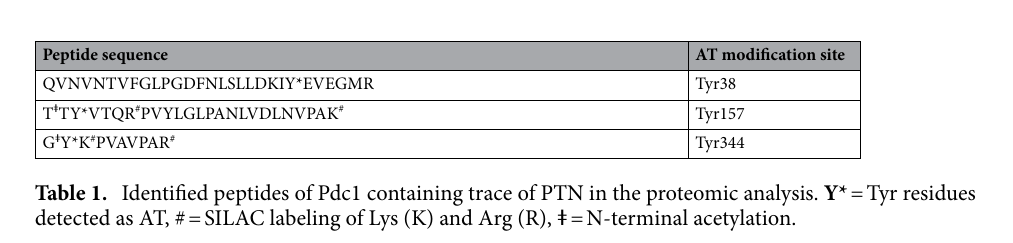
Figure 1. Effect of acidified nitrite on ethanol production and the related enzymatic activity. ( A ) Ethanol concentration in the culture medium, or ( B ) intracellular pyruvate content of yeast with or without acidified nitrite treatment was analyzed. Each content was normalized by OD 600 of the culture medium. ( C ) PDC, or ( D ) ADH activity in the cell-free extract from yeast exposed to acidified nitrite was measured. The values represent the averages and standard deviations from three independent experiments. ** ρ < 0.01 by Student’s t -test.